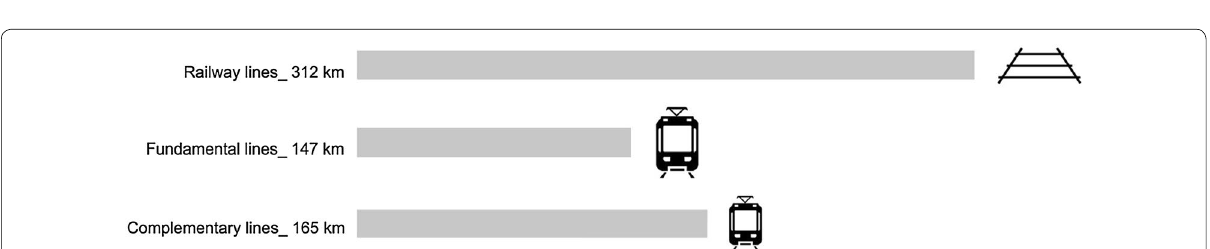
Fig. 3 Classification of railway lines in proximity with the VENTO path (part considered in the